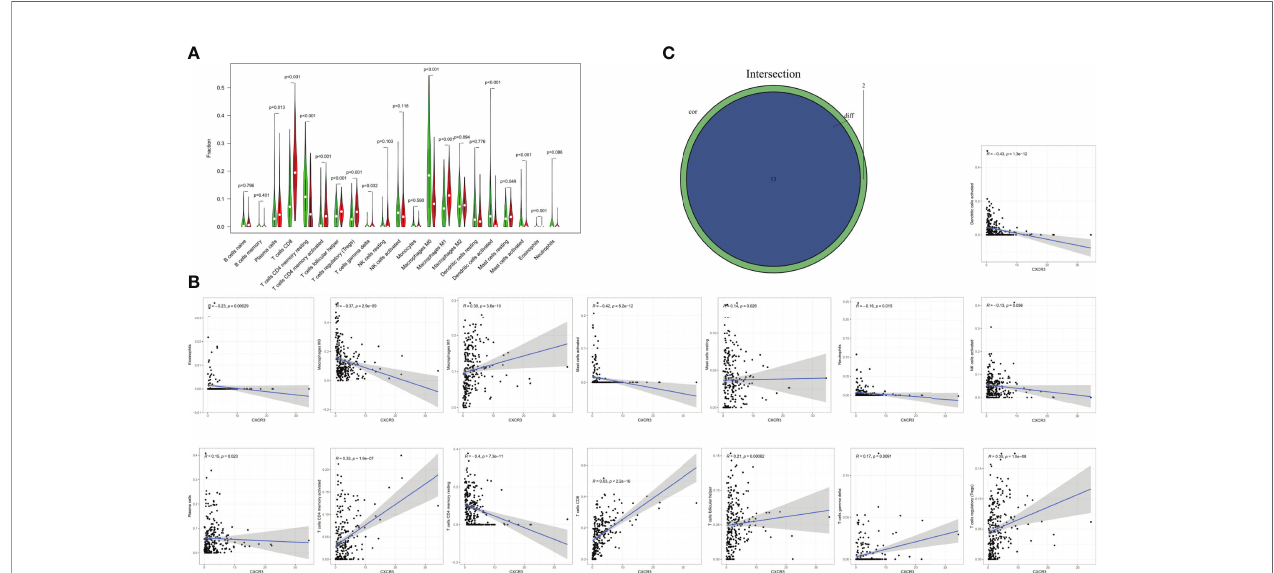
FIGURE 8 | Correlation of TICs proportion with CXCR3 expression. (A) Violin plot showed the ratio differentiation of 21 kinds of immune cells between CESC tumor samples with low or high CXCR3 expression relative to the median of CXCR3 expression level, and Wilcoxon rank sum was used for the signi fi cance test. (B) Scatter plot showed the correlation of 15 kinds of TICs proportion with the CXCR3 expression (p<0.05). The blue line in each plot was fi tted linear model indicating the proportion tropism of the immune cell along with CXCR3 expression, and Pearson coef fi cient was used for the correlation test. (C) Venn plot displayed 13 kinds of TICs correlated with CXCR3 expression codetermined by difference and correlation tests displayed in violin and scatter plots,